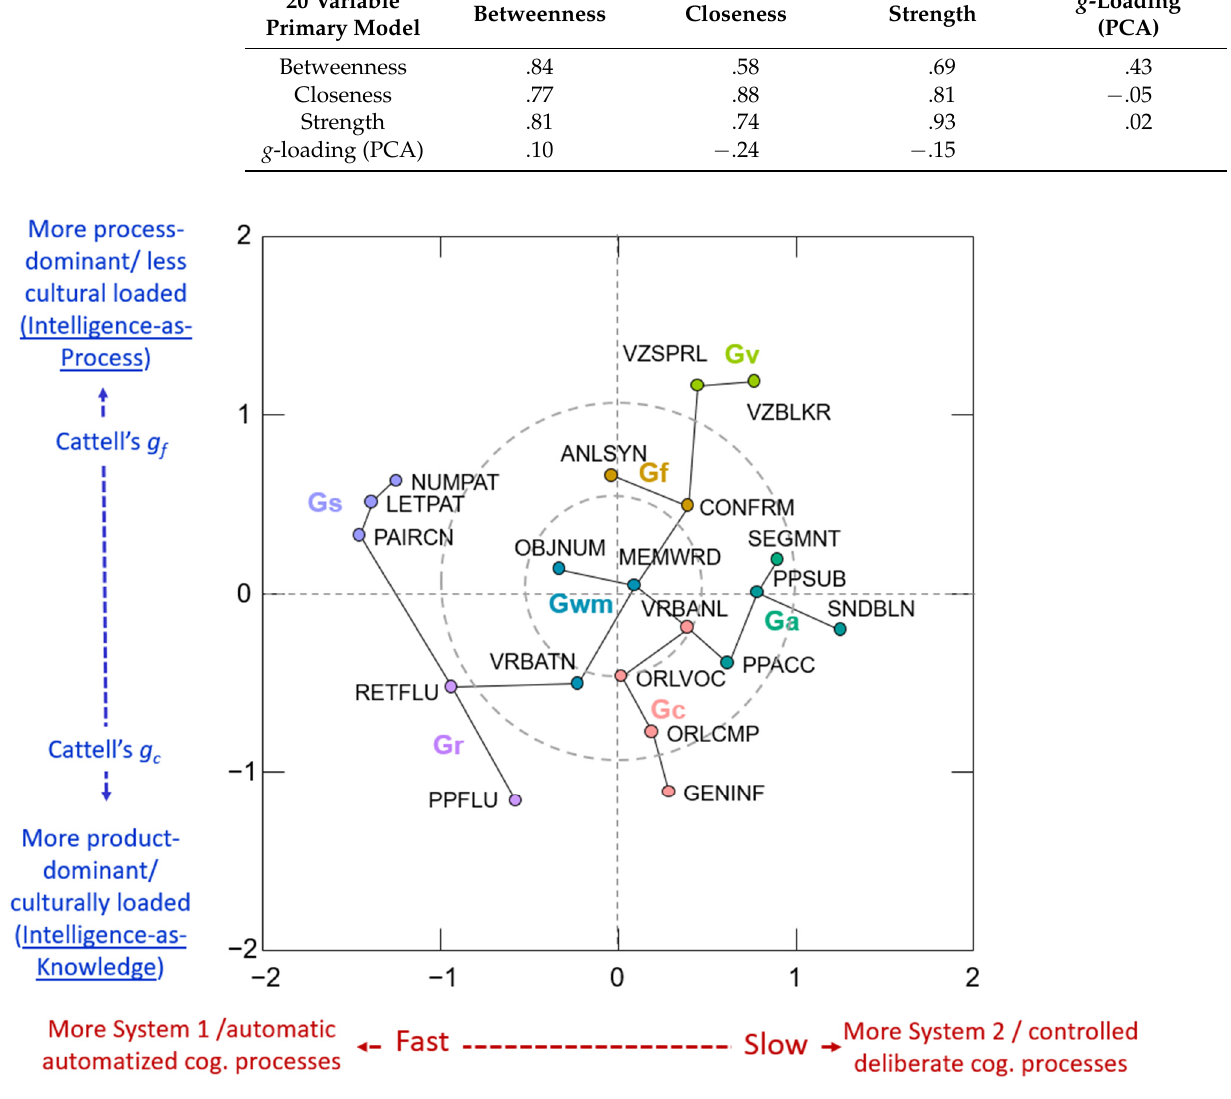
Figure 3. 2 ‐ D MDS analysis (Guttman Radex) of a 20 ‐ measure primary model connected by the MST Figure 3. 2-D MDS analysis (Guttman Radex) of a 20-measure primary model connected by the MST algorithm.